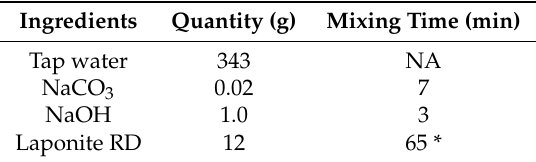
Table 4. Mix design and mixing procedure for the laponite pill.